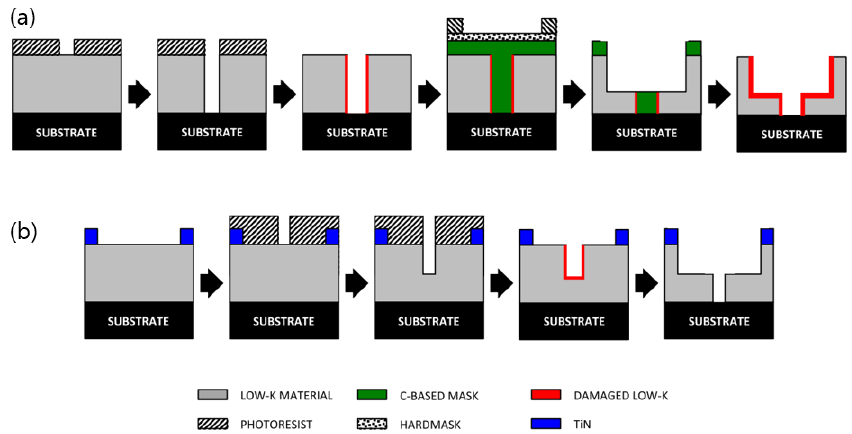
Figure 3. Process flow for ( a ) via-first and ( b ) trench-first approaches with a metal hard mask (HM) [11]. The plasma damage to the low-k material is lower for the trench-first scheme. Patterned profiles created using the DD process need to be filled using